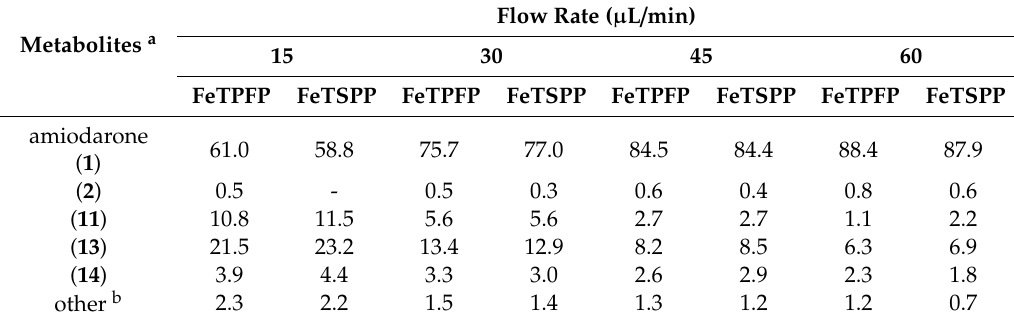
Table 4. Metabolite profile of amiodarone from immobilized metalloporphyrin (MNPs-NH-FeTPFP